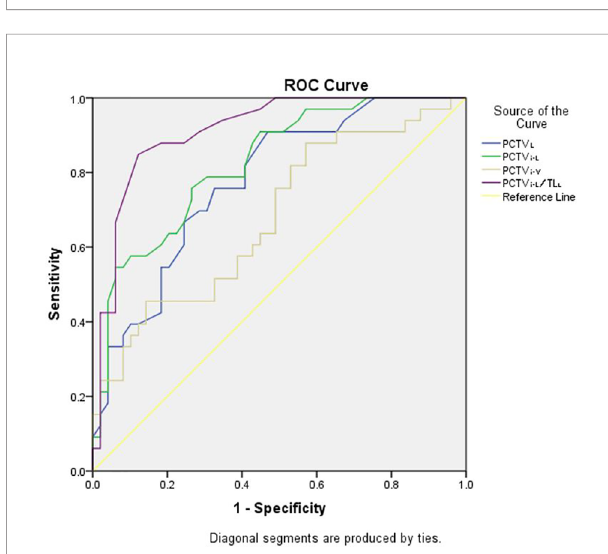
FIGURE 3 | ROC analysis curves of F-VMAT for PCTV L , PCTV i-V , PCTV i-L and PCTV i-L /TL L .